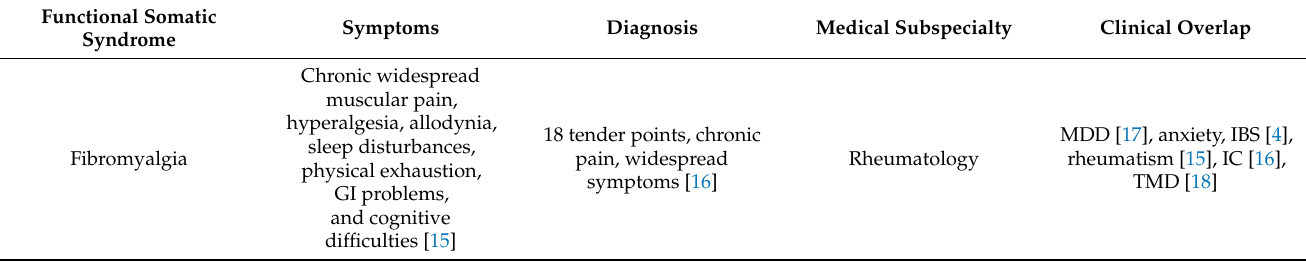
Table 1. Outlining FSSs, symptoms, diagnosis, common co-morbidities, or clinical overlap. Functional Somatic